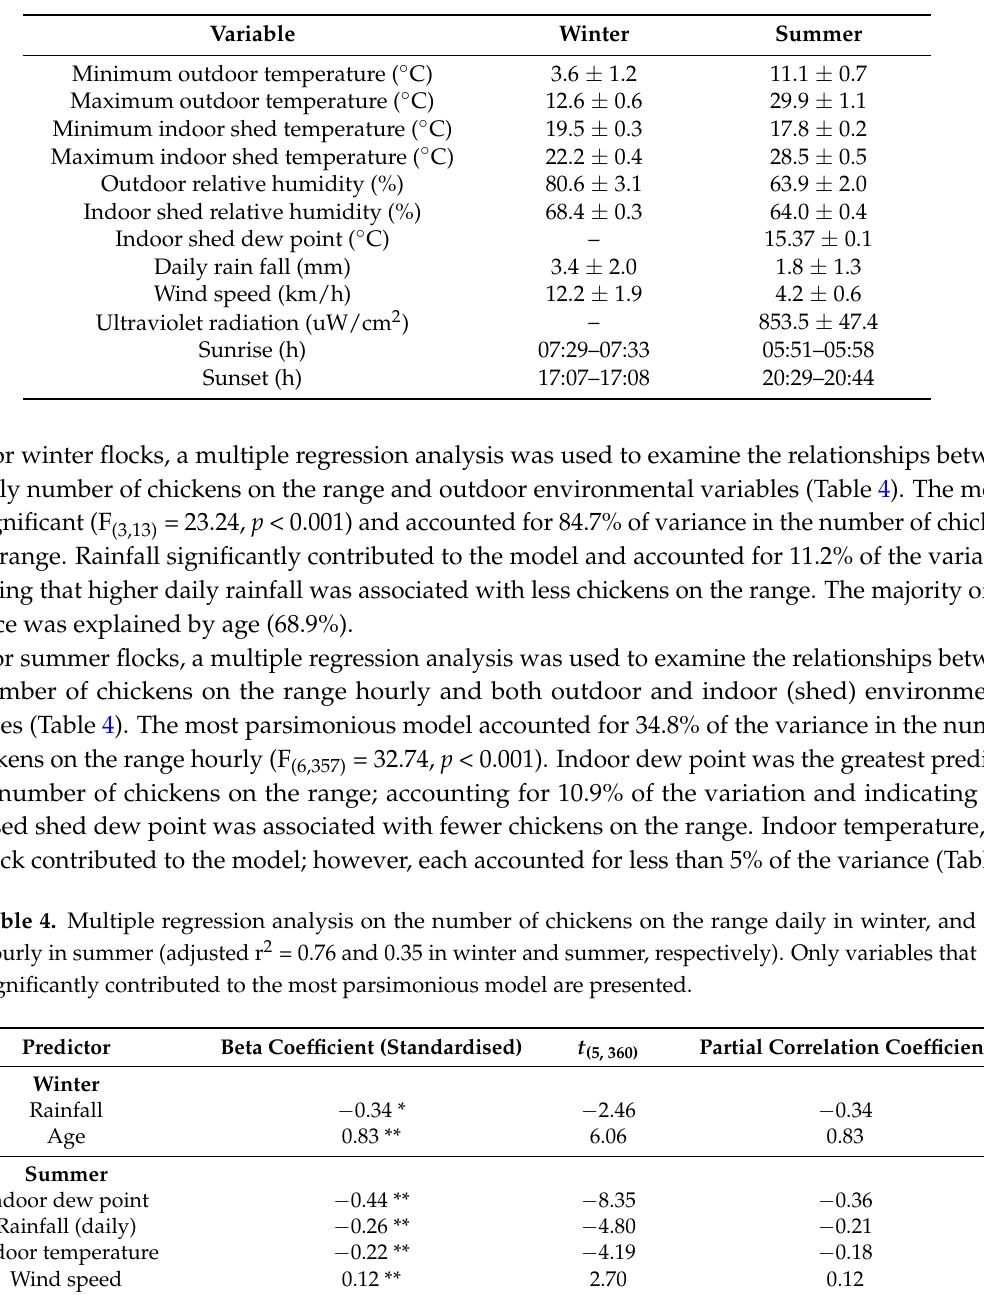
Table 3. Mean daily ( ± Standard Error (SE)) environmental conditions in winter ( n = 8 days) and summer ( n = 26 days). Environmental conditions were measured twice daily in winter and at ten minute intervals in summer.